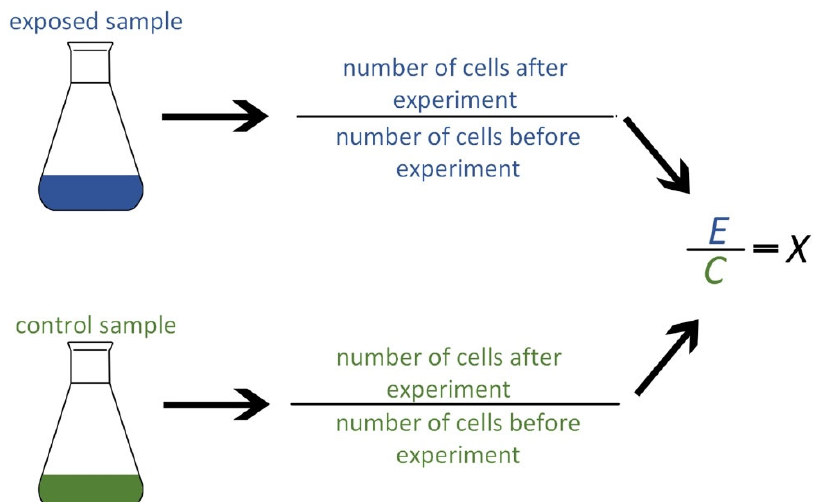
Figure 3. The calculation method developed for quantification of the MF effect—representing a growth dynamics coefficient ratio.